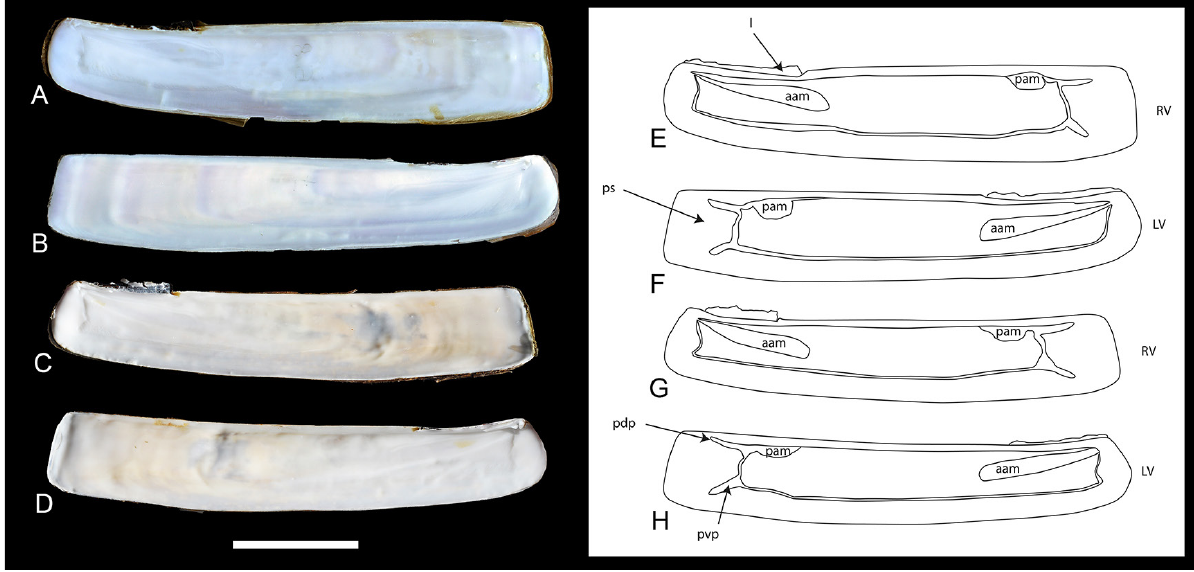
Fig. 6. – Morphological comparison between Ensis loboi n. sp. and E. macha . A-B, E-F: E. loboi n. sp. C-D, G-H: E. macha . Scale bar = 4